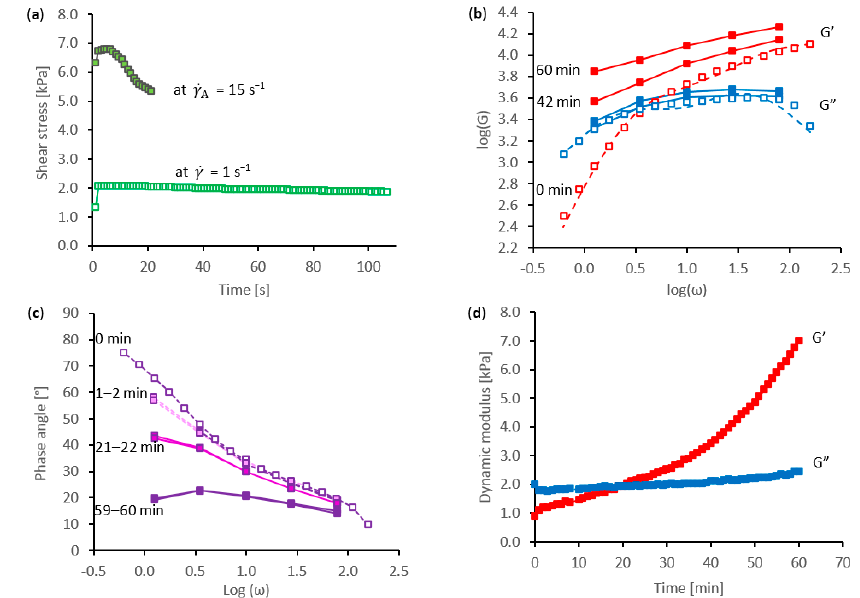
Figure 1. Rheological demonstration of shear-induced phase change: ( a ) shear stress during steady flow at shear rates of 1 and 15 s − 1 , where the latter period of high shear stress initiated the phase change; ( b ) examples of dynamic moduli; ( c ) examples of frequency dependence of the phase angle; ( d ) progressive changes in dynamic moduli measured at 0.2 Hz (1.25 rad·s − 1 ). Open points indicate initial data prior to initiation; filled points indicate data during the phase change.